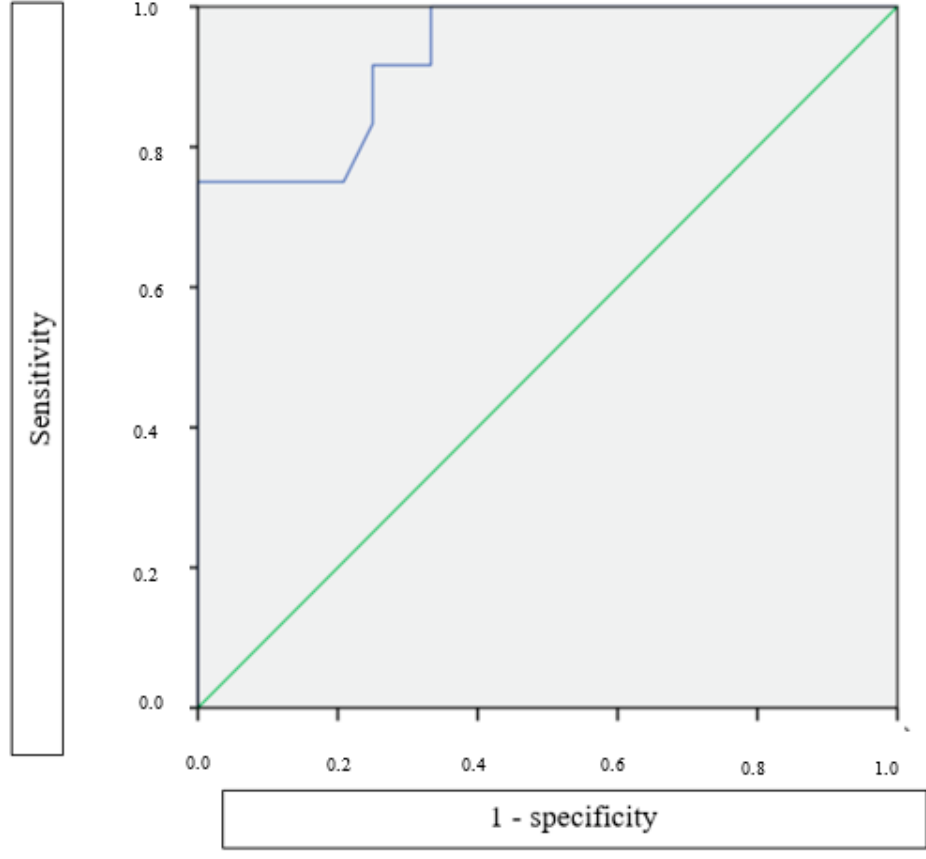
Figure 4. Receiver operating characteristic (ROC) curve of ADOS and BSID scores combined at 18 months, measuring their ability of predicting ASD at 24 months. AUC: area under the curve; AUC = 0.944 (95% CI: 0.873–1.000).